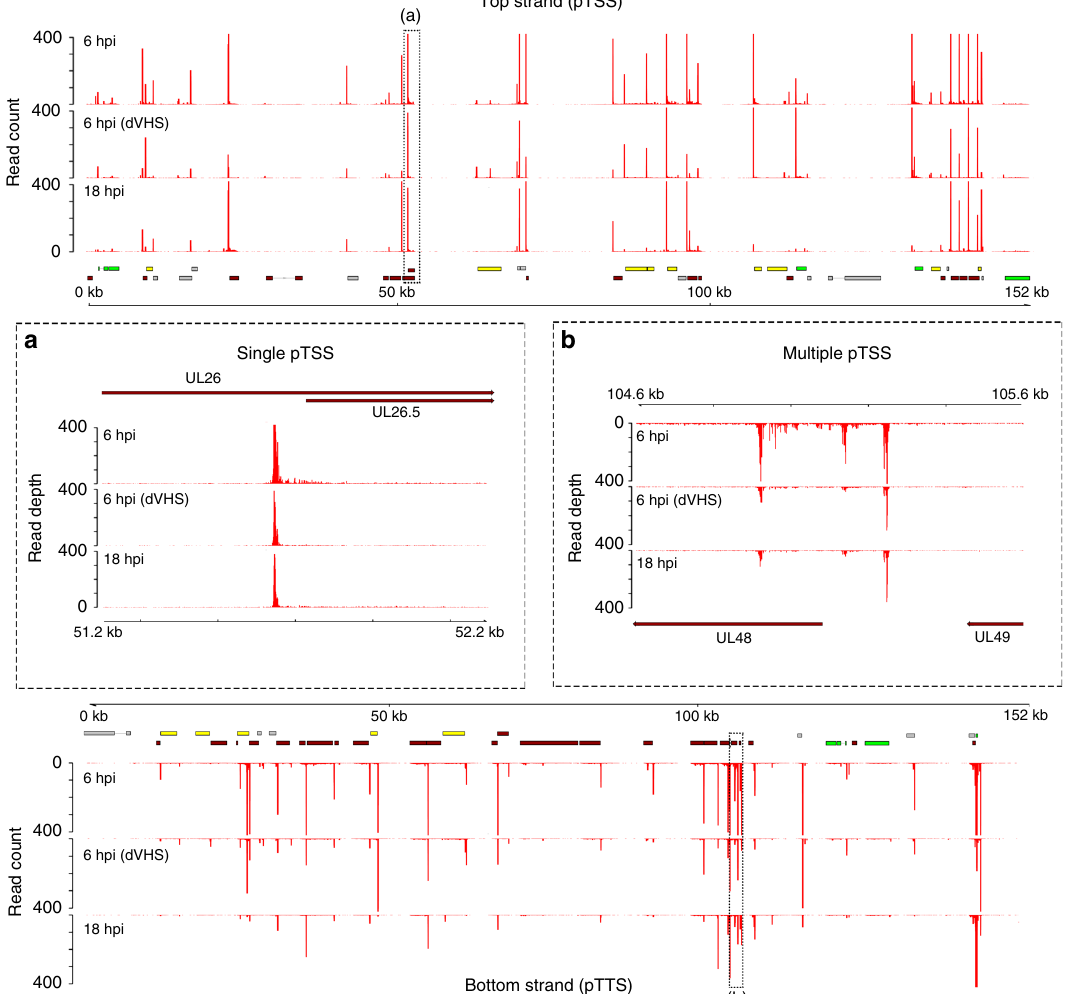
Fig. 4 Viral polyadenylated RNAs initiate at single or multiple locations. To visualize transcription start sites, the extreme 5 ′ end of each nanopore read was plotted against the HSV-1 genome. Datasets correspond to NHDF infected with HSV-1 strain Patton for 6 hpi (upper track), strain F Δ vhs for 6 hpi (middle track), and strain Patton for 18 hpi (lower track). Peaks corresponding to clustered 5 ′ ends, are referred to as proximal transcription start sites (pTSS) and likely differ by only a few nucleotides from the actual capped 5 ′ end. In 13 cases, the pTSS is positioned 30 – 48 bp downstream of a canonical TATA box. Upper panel: top strand. Lower panel: bottom strand. Inset boxes: a Transcription of the HSV-1 UL26.5 gene initiates at a single location throughout infection. b UL48 transcription initiates at multiple locations, one of which is internal to the canonical UL48 ORF, suggesting transcripts encoding a truncated or alternative protein. Canonical HSV-1 ORFs are colored according to kinetic class (IE — green, E — yellow, L — red, and unde fi ned — gray), while polycistronic transcriptional units are indicated by hatched